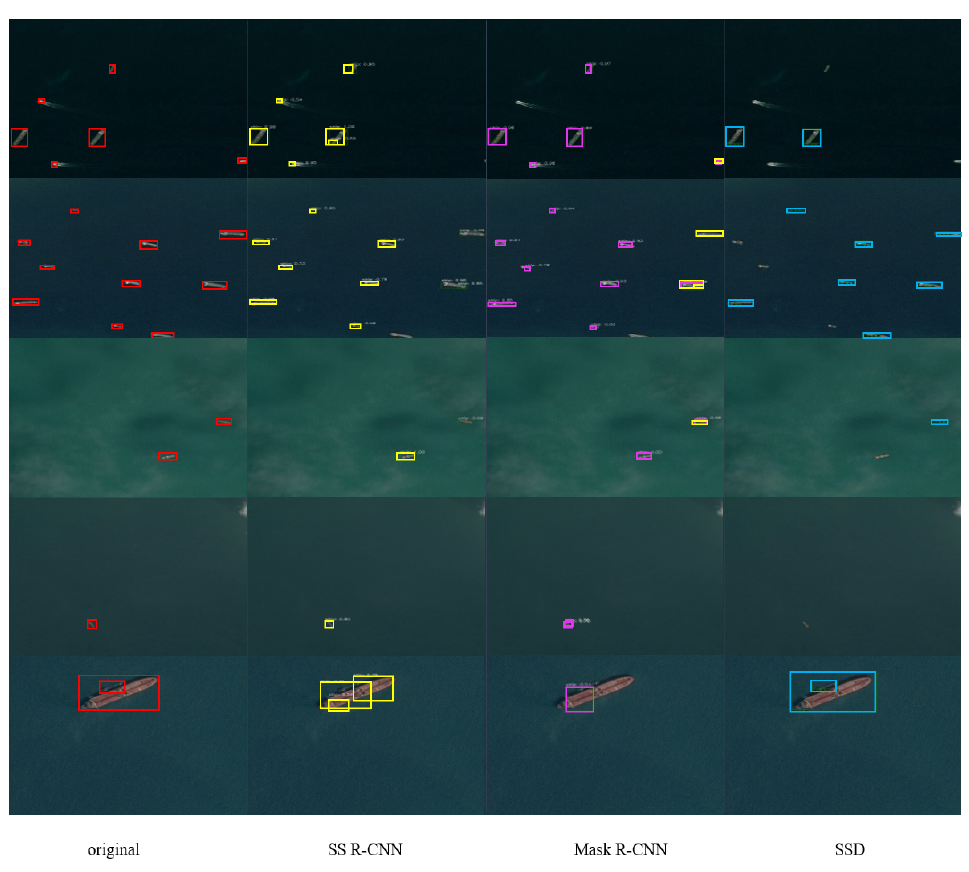
Figure 5. Detected ships of the tested methods. The leftmost column displays several typical remote sensing images, including scenarios with multiple ships (the first two rows), middle-sized ships (the third row), small ships (the fourth row), and large ships accompanied by small boats (fifth row). The following columns display the ships detected by SS R-CNN, SSD, and Mask RCNN, respectively, in different images. The detected ships are marked with rectangles, while the red rectangles in the first column are the ground-truth boxes of the